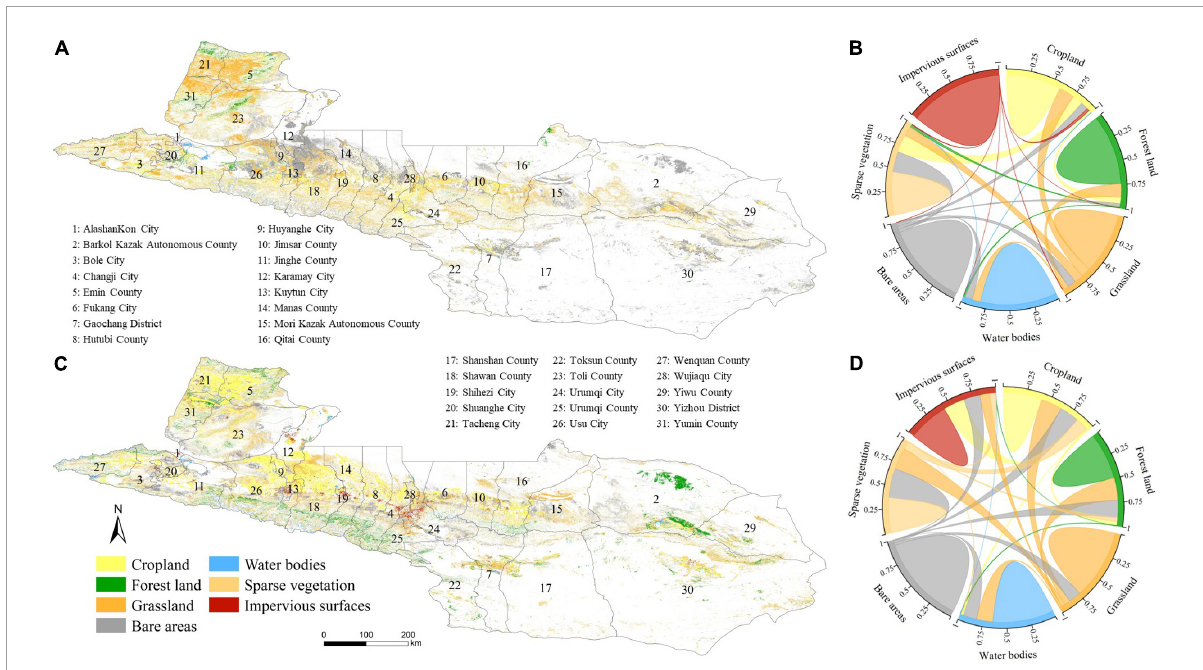
FIGURE5 Land use change from 1990 to 2020 in the NSTM. The spatial distribution (A) and its outflow proportion (B) of each category to other categories based on land use structure in 1990. The spatial distribution (C) and its inflow proportion (D) of each category from other categories based on land use structure in